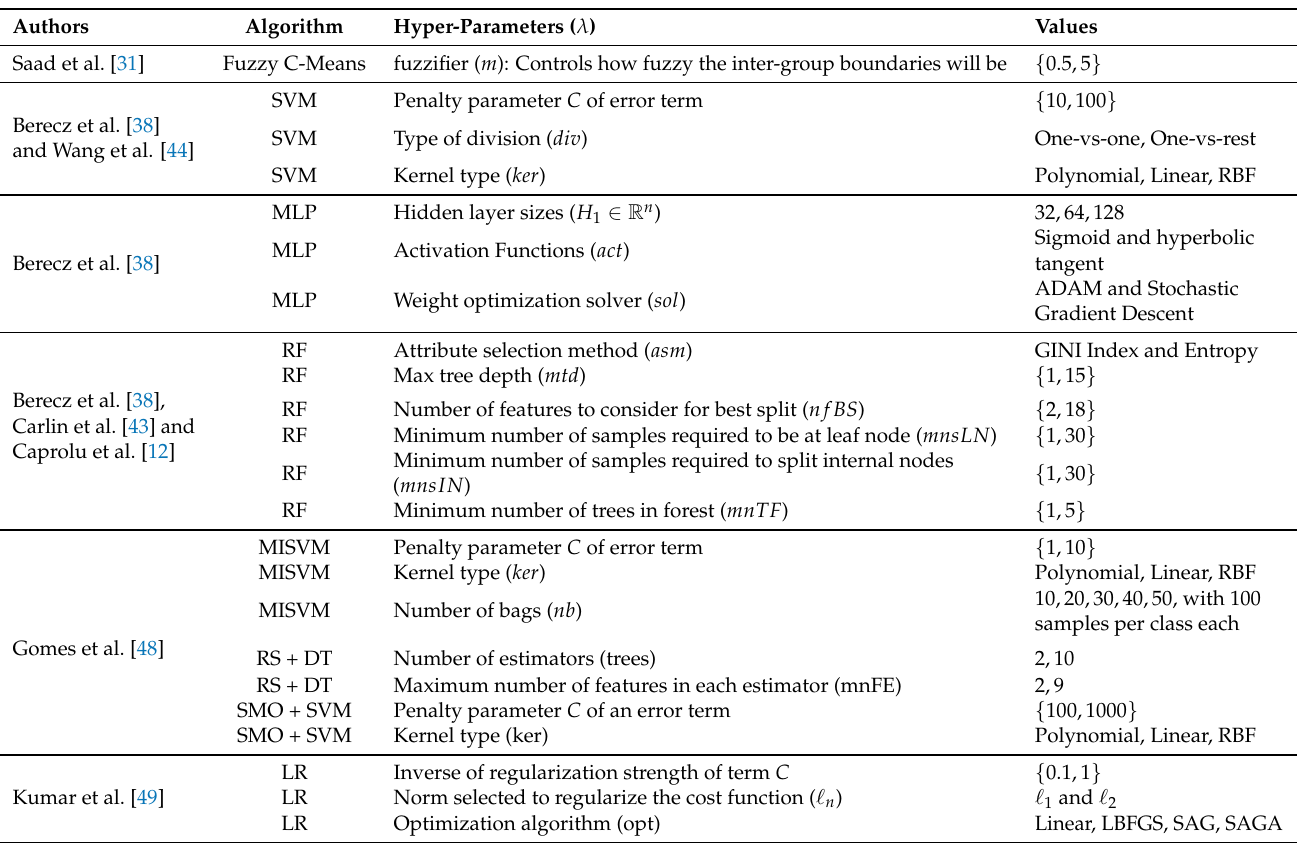
Table 8. List of selected authors who have presented solution proposals regarding cryptojack- ing, using shallow algorithms. The λ hyper-parameters to be evaluated and then optimized are described.